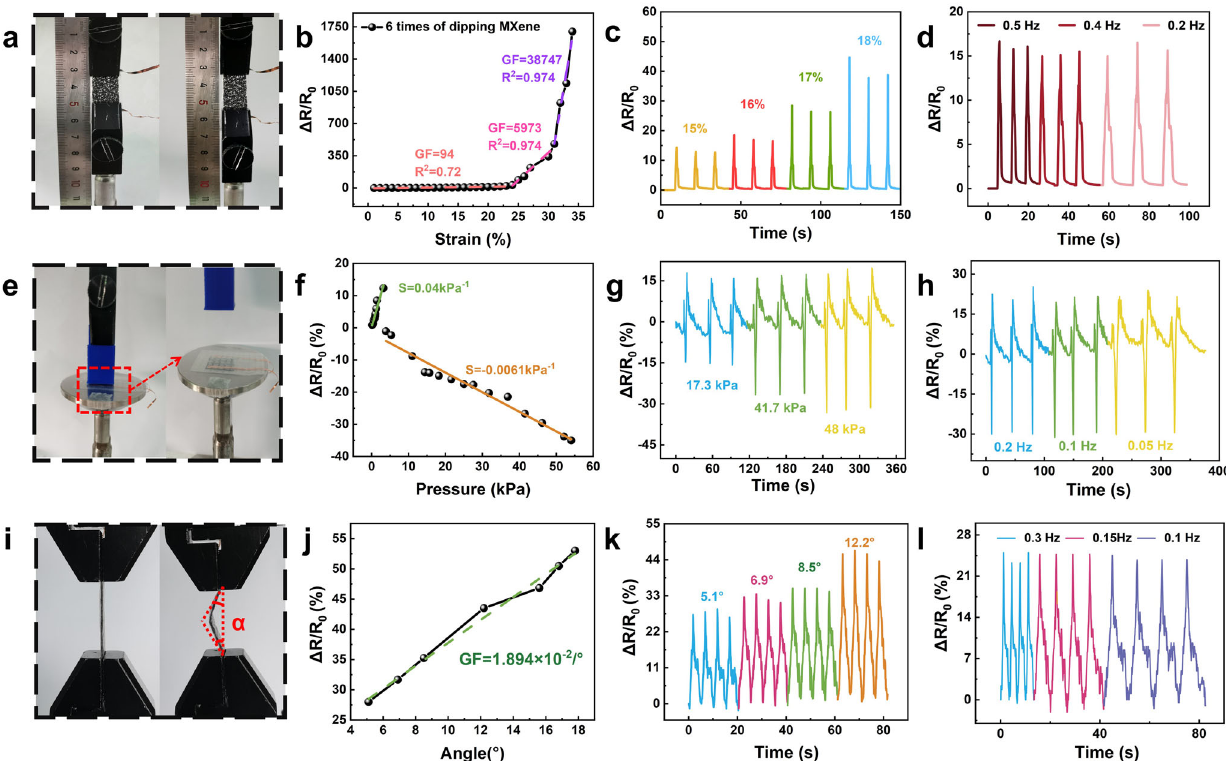
Fig. 4 Sensing property of the PMPPF Sensor. a – d Stretching sensor: a Digital image of stretching test device. b GF of the PMPPF sensor impregnated with the 6 times MXene at different strains (1% – 35%). c Relative resistance changes of the sensor under stretch-release cycles at a maximum strain of 15%, 16%, 17%, and 18%, respectively. d Relative resistance changes of the sensor under stretch-release cycles at 0.2, 0.4, and 0.5 Hz, respectively. e – h Compression sensor: e Digital image of compress device. Blue column is plastic block (area of thrust surface: 1.5 cm × 1.5 cm). f GF of PMPPF sensor impregnated with the 6 times MXene at different pressure (0.13 kPa – 53 kPa). g Relative resistance changes of the sensor under compress-release cycles at a maximum pressure of 17.3 kPa, 41.7 kPa, and 48 kPa, respectively. h Relative resistance changes of the sensor under compress-release cycles at 0.2, 0.1, and 0.05 Hz, respectively. i – l Bending sensor: i Digital image of bend device. j GF of the PMPPF sensor impregnated with the 6 times MXene at different bend angles (5.1° – 17.8°). k Relative resistance changes of the sensor under bend-release cycles at a maximum bend angle of 5.1°, 6.9°, 8.5°, 12.2°, respectively. l Relative resistance changes of the sensor under bend-release cycles at 0.3, 0.15, and 0.1 Hz,